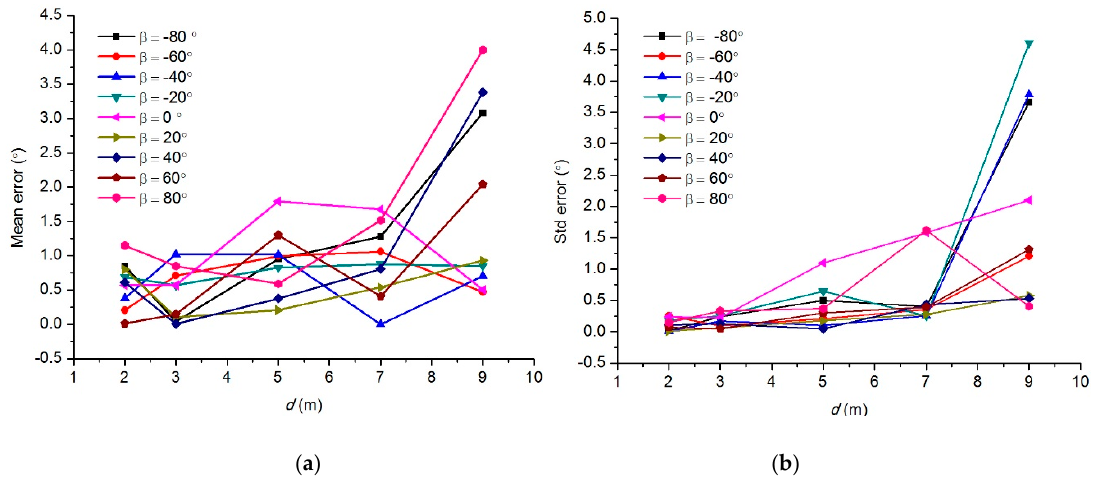
Figure 17. Mean angular measurement errors and error standard deviation of the test points. ( a ) Mean angular measurement errors. ( b ) Error standard deviation.